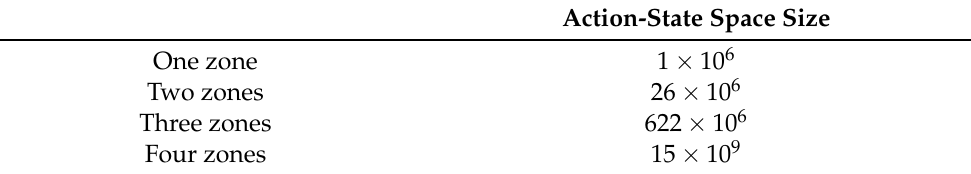
Table 1. Size of action-state space for a one, two, three and four-zone UFH system. The action-state space grows exponentially with the number of temperature zones. Assumptions about the number of discrete values each action or state has: T supply ; 15, Valve per zone; 2, T room per zone; 12, T amb ; 30, heat consumption; 10, sun;